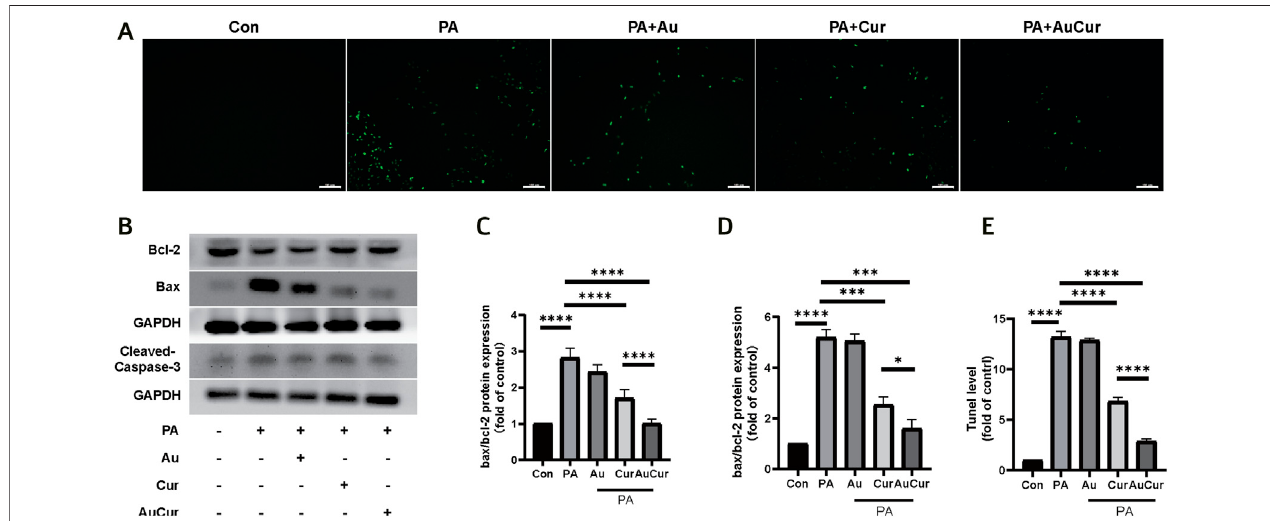
FIGURE 5 | Effects of AuCur on apoptosis of myocardial cells induced by PA. (A) TUNEL images of Control, PA, PA + Au, PA + Cur, and PA + AuCur. Scale bar: 100 μ m. (B) WB was used to detect the expression of Bax, Bcl-2, and Cleaved-caspase-3. GAPDH was used as internal reference. (C – D) Analysis of Bax, Bcl-2, Cleaved caspase-3 bands. (E) Image analysis by TUNEL. * p < 0.05.